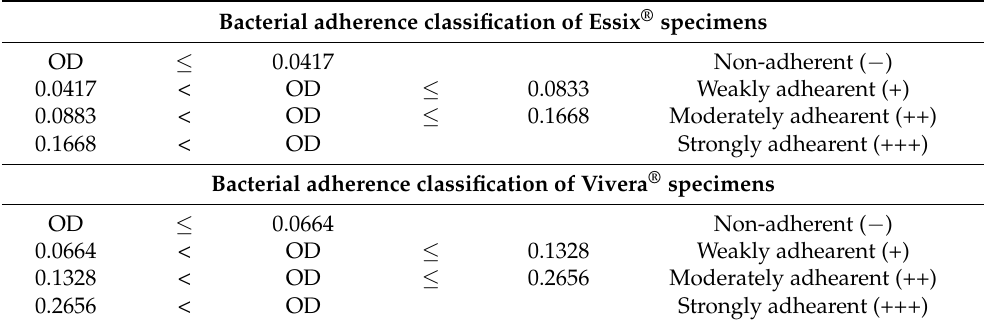
Table 1. The classification of bacterial adherence on Essix ® and Vivera ®